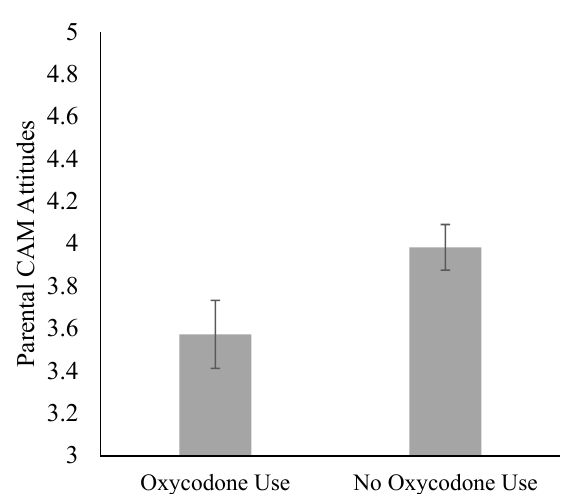
Figure 3. Within-person relationship between a child’s daily pain intensity and predicted ibuprofen doses administered. Daily Pain Intensity is within-person centered where a higher score indicates greater pain intensity on a given day compared to a child’s average across the postoperative period.